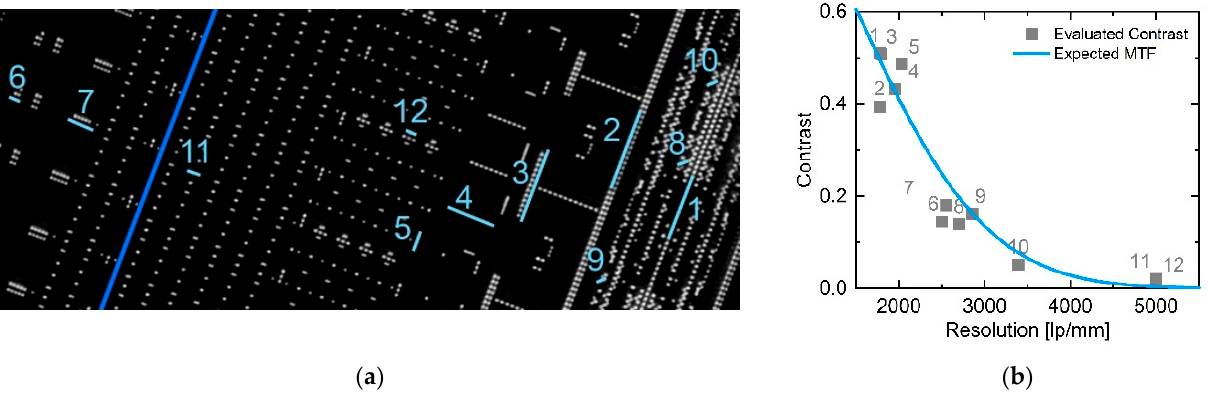
Figure 6. Application of the local image contrast ratio at different structures in the horizontal section of the semiconductor memory dataset ( a ) which are assumed to be approximately periodic and comparison with the previously determined MTF ( b ). (All sectional images shown were exported with ImageJ Fiji [44]. Additionally in this software, the local contrast was extracted as a line profile of the gray values over the selected structure) The corresponding areas in the image are marked accordingly. Points 11 and 12 are roughly on a par with an expectable noise level and should therefore only be evaluated as image contrast with